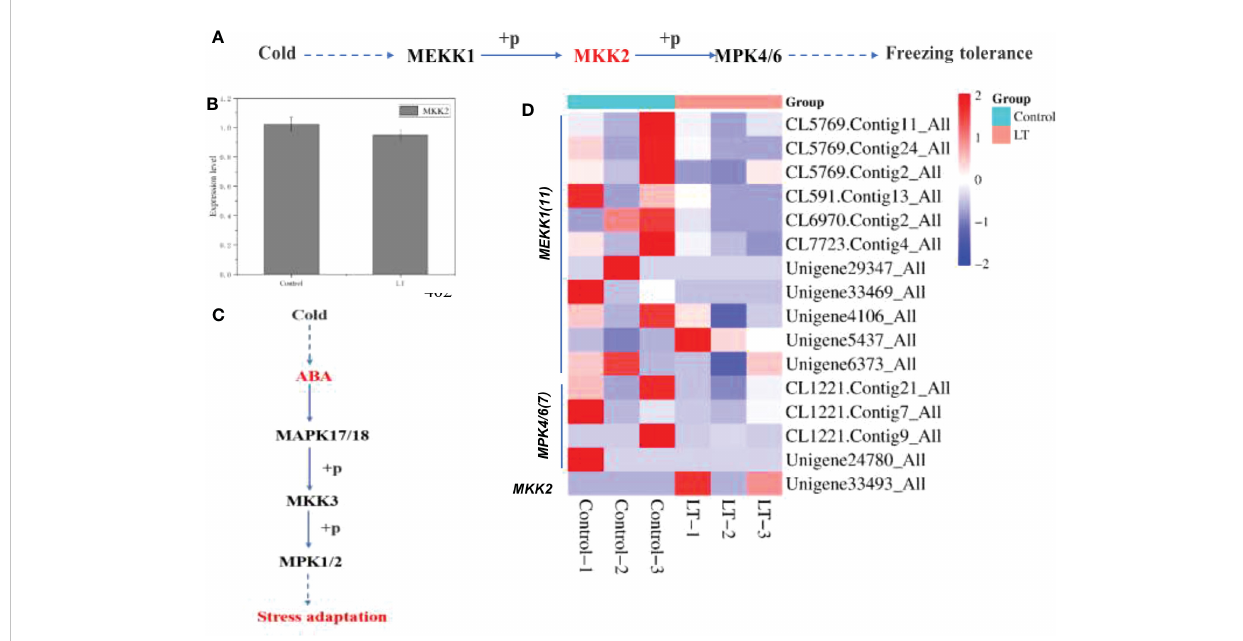
FIGURE 5 Sensing cold signal related metabolic pathway of R. chrysanthum . (A) MAPK signaling pathway to freezing cold stress. (B) The expression of MKK2 was down-regulated under cold stress. (C) ABA regulates the adaptation of plant MAPK signaling pathway to stress under cold stress. (D) Heat map clustering analysis of MAPK signaling pathway genes after cold stress according to their expression levels.